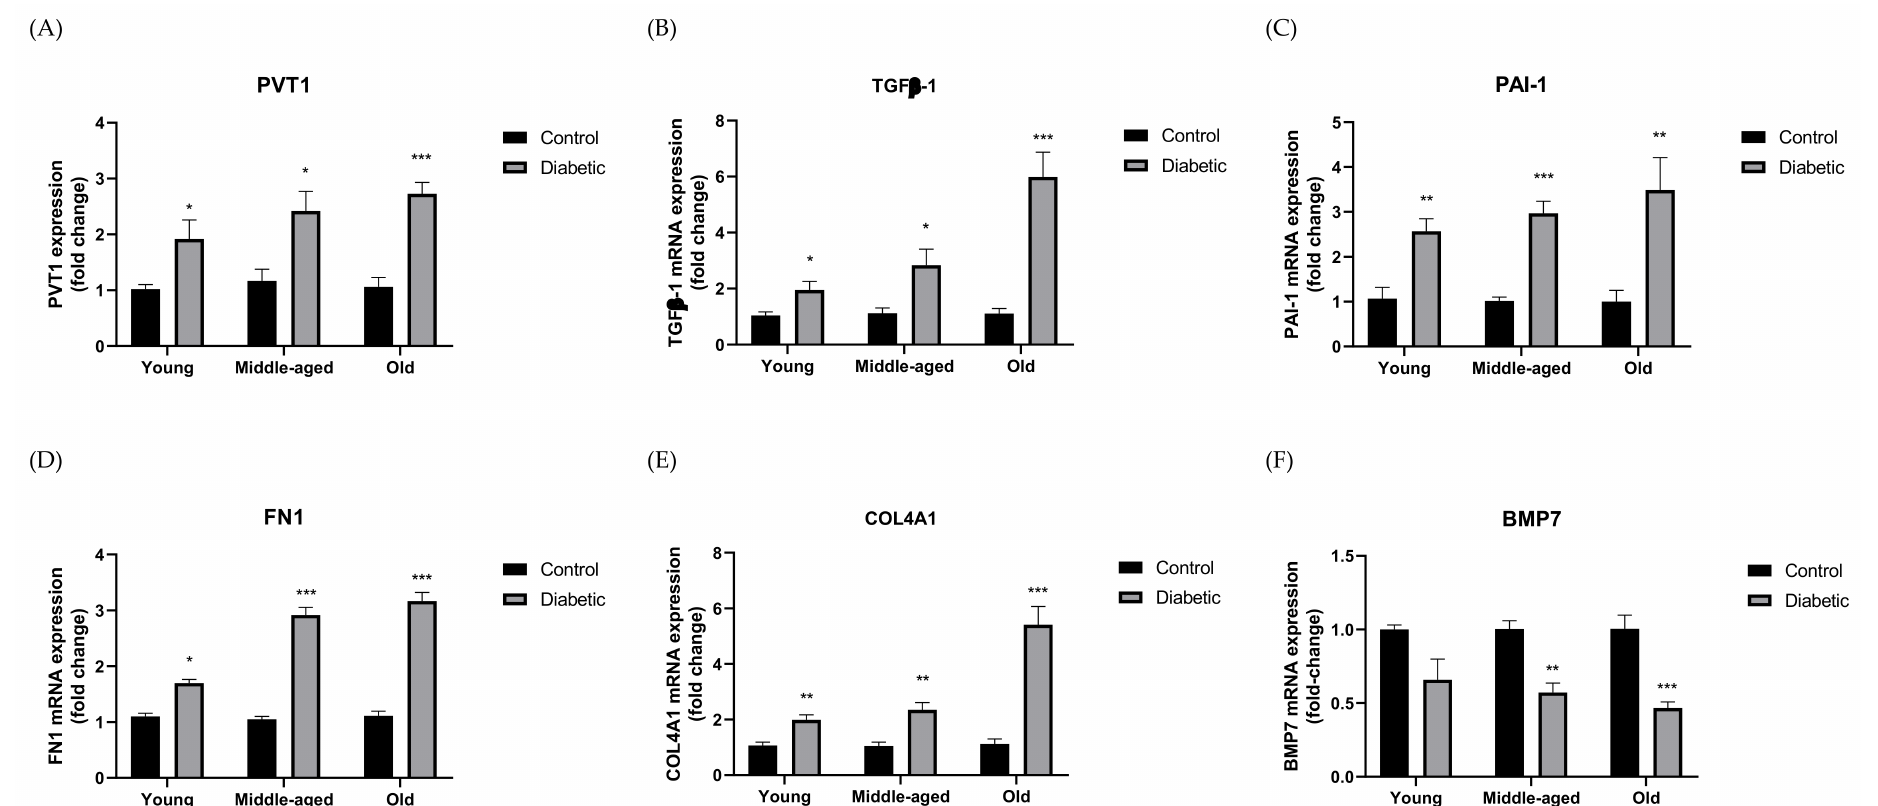
Figure 1. Gene expressions of ( A ) PVT1, ( B ) TGF- β 1, ( C ) PAI-1, ( D ) FN1, ( E ) COL4A1, and ( F ) BMP7 of diabetic and control mice of different age groups. The diabetic group and normal control group were represented by the HFD-STZ-treated mice and the LFD-vehicle-treated mice, respectively. Data were presented as means ± SEM, n = 6. A p -value < 0.05 was considered statistically significant using unpaired Student’s t -test (* p < 0.05, ** p < 0.01, *** p < 0.001 vs. age-matched control). PVT1 (Plasmacytoma variant translocation 1); TGF- β 1 (Transforming growth factor beta 1); PAI-1 (Plasminogen activator inhibitor-1); FN1 (Fibronectin 1); COL4A1 (Collagen type IV alpha 1); BMP7 (Bone morphogenetic protein